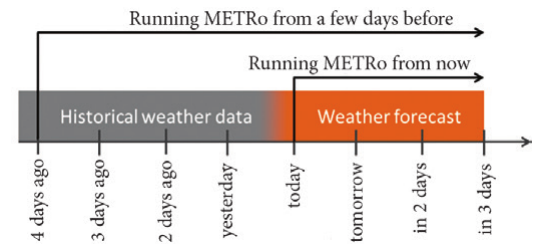
Fig. 3. Starting Road Weather Model from the current day or a few days before